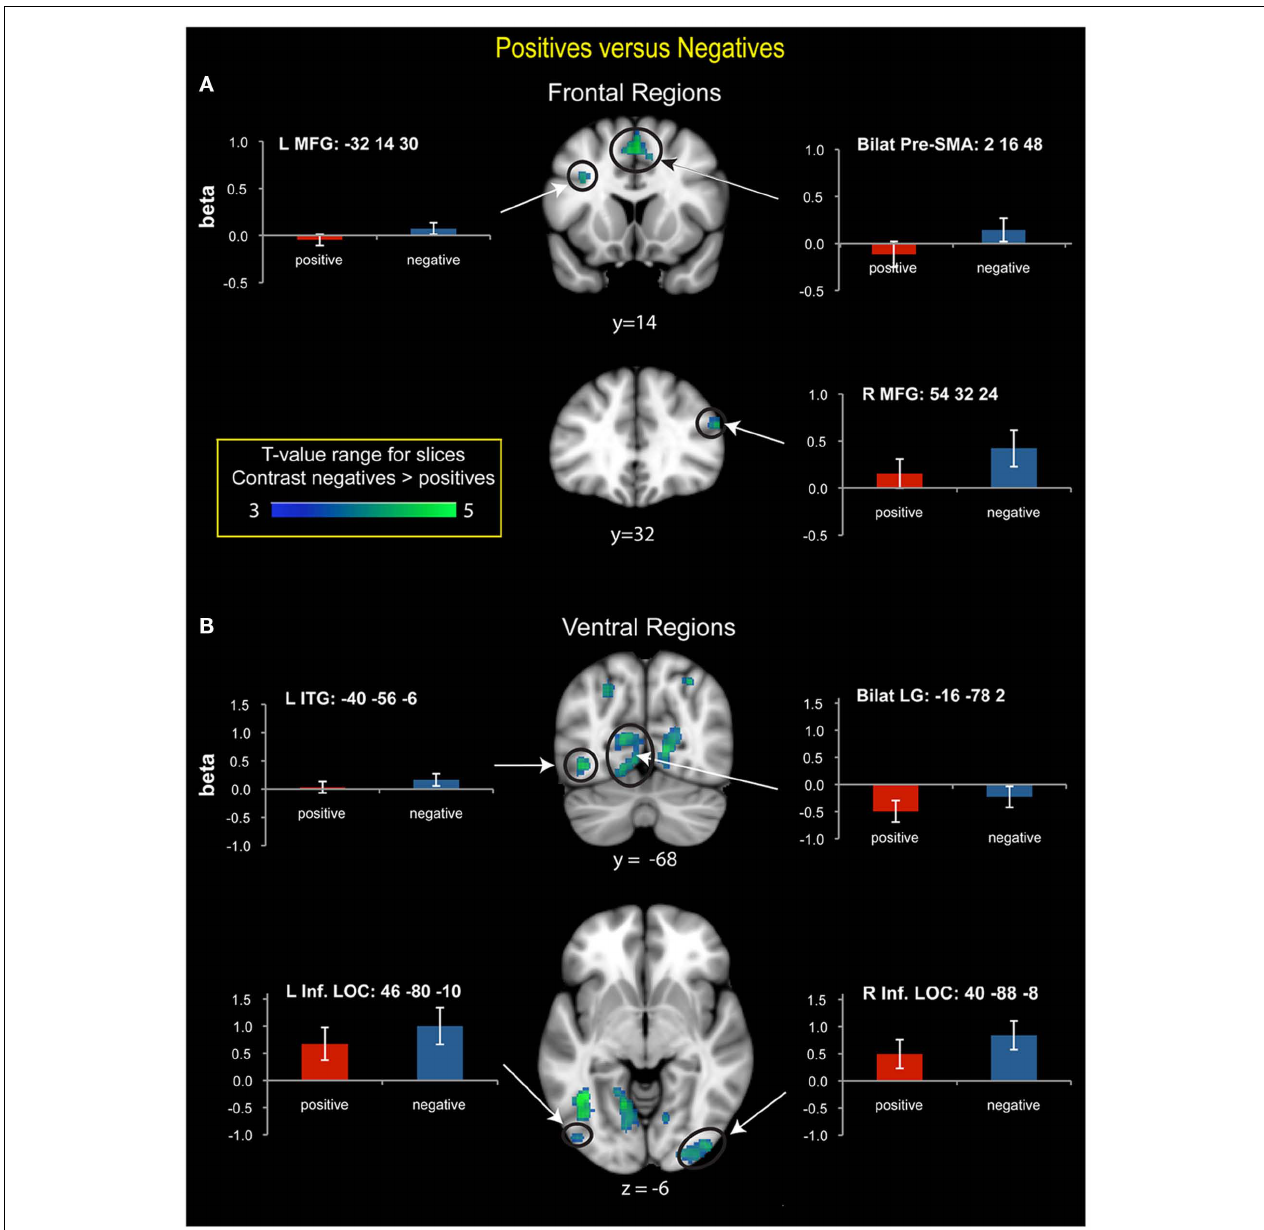
negative numbers was detected in the bilateral lingual gyrus (LG), which was driven by greater deactivation for positive numbers. In the bilateral inferior lateral occipital cortex (LOC) there was strong activation above baseline for both number types, with greater activation for negative numbers. In the left inferior temporal gyrus (ITG), activation was greater for negative numbers, though it did not differ from baseline for either number